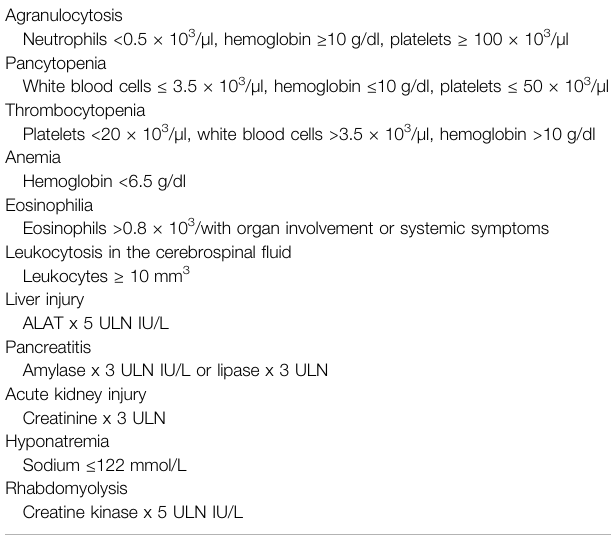
TABLE 1 | De fi nition of automatic laboratory signals used to detect serious adverse drug reactions. Agranulocytosis Neutrophils < 0.5 × 10 3 /µl, hemoglobin ≥ 10 g/dl, platelets ≥ 100 × 10 3 /µl Pancytopenia White blood cells ≤ 3.5 × 10 3 /µl, hemoglobin ≤ 10 g/dl, platelets ≤ 50 × 10 3